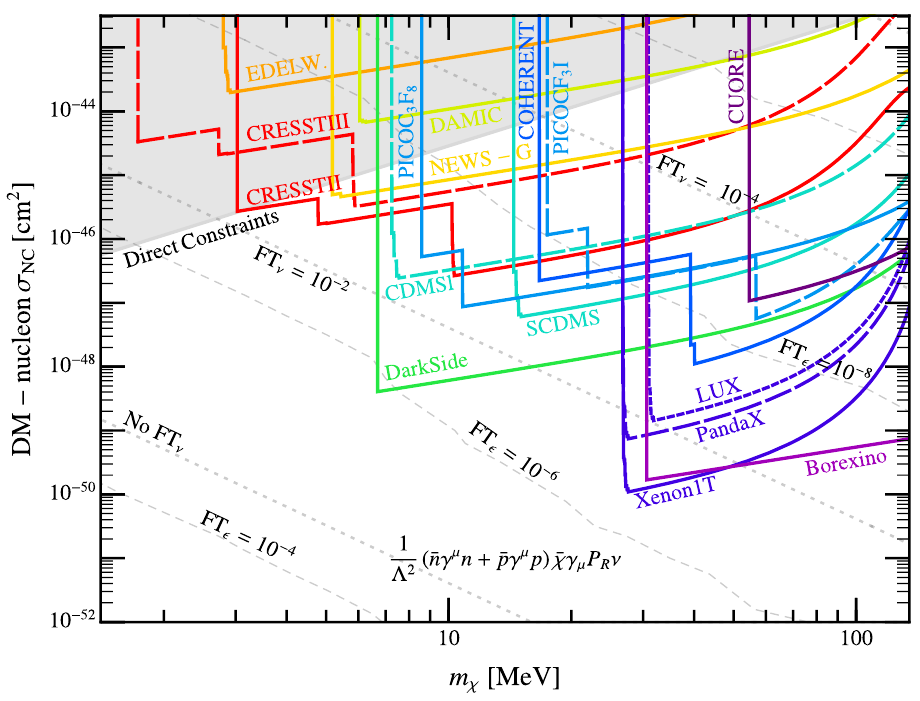
Figure 4 . Projected upper bound on (cid:27) NC as a function of m (cid:31) at current experiments, including CUORE [73] (dark purple), Borexino [74] (purple), LUX [1] (dotted navy blue), PandaX-II [75] (dashed navy blue), XENON1T [76] (solid navy blue), COHERENT [77, 78] (blue), PICO-60 run with CF 3 I [79] (dashed sky blue), PICO-60 run with C 3 F 8 [80] (solid sky blue), SuperCDMS [81] (solid aqua), CDMSlite Run 2 [82] (dashed aqua), DarkSide-50 [83, 84] (green), DAMIC [85] (lime), NEWS-G [86] (yellow), EDELWEISS-SURF [87] (orange), CRESST II [88] (solid red), and CRESST III [72] (dashed red). Here we have taken m Z 0 = 18 GeV, s (cid:18) = 10 (cid:0) 2 , and Q (cid:31) = 0 : 1. Also shown R are the constraints from direct searches for Z 0 s and decays of (cid:31) for the benchmark point chosen, as described in the text. The dashed grey contours show the level of (cid:12)ne-tuning necessary in our UV completion to avoid rapid (cid:31) ! (cid:23)e + e (cid:0) and (cid:31) ! (cid:23)(cid:23)(cid:23) decays in tension with indirect detection bounds [49,